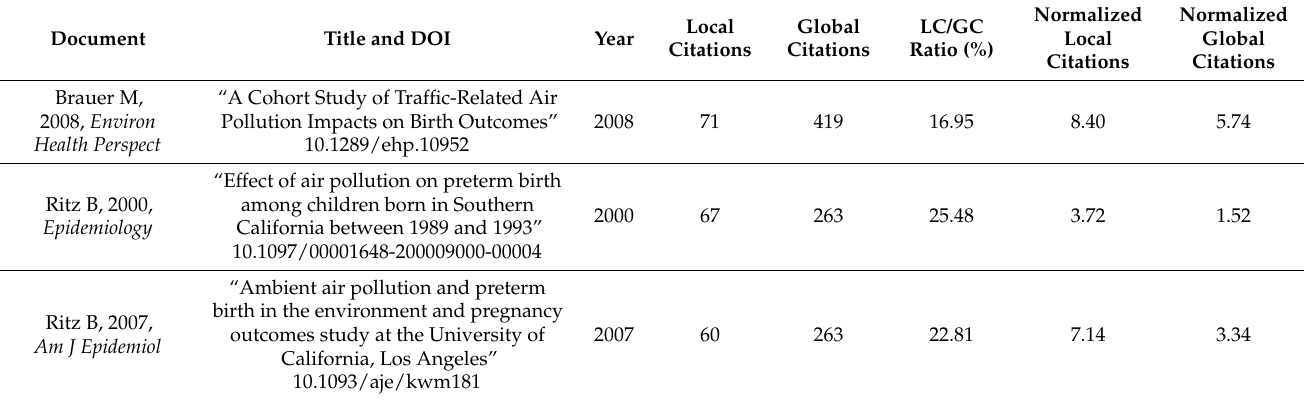
Table 1. Most cited documents on environmental toxicants and pollutants and preterm birth.